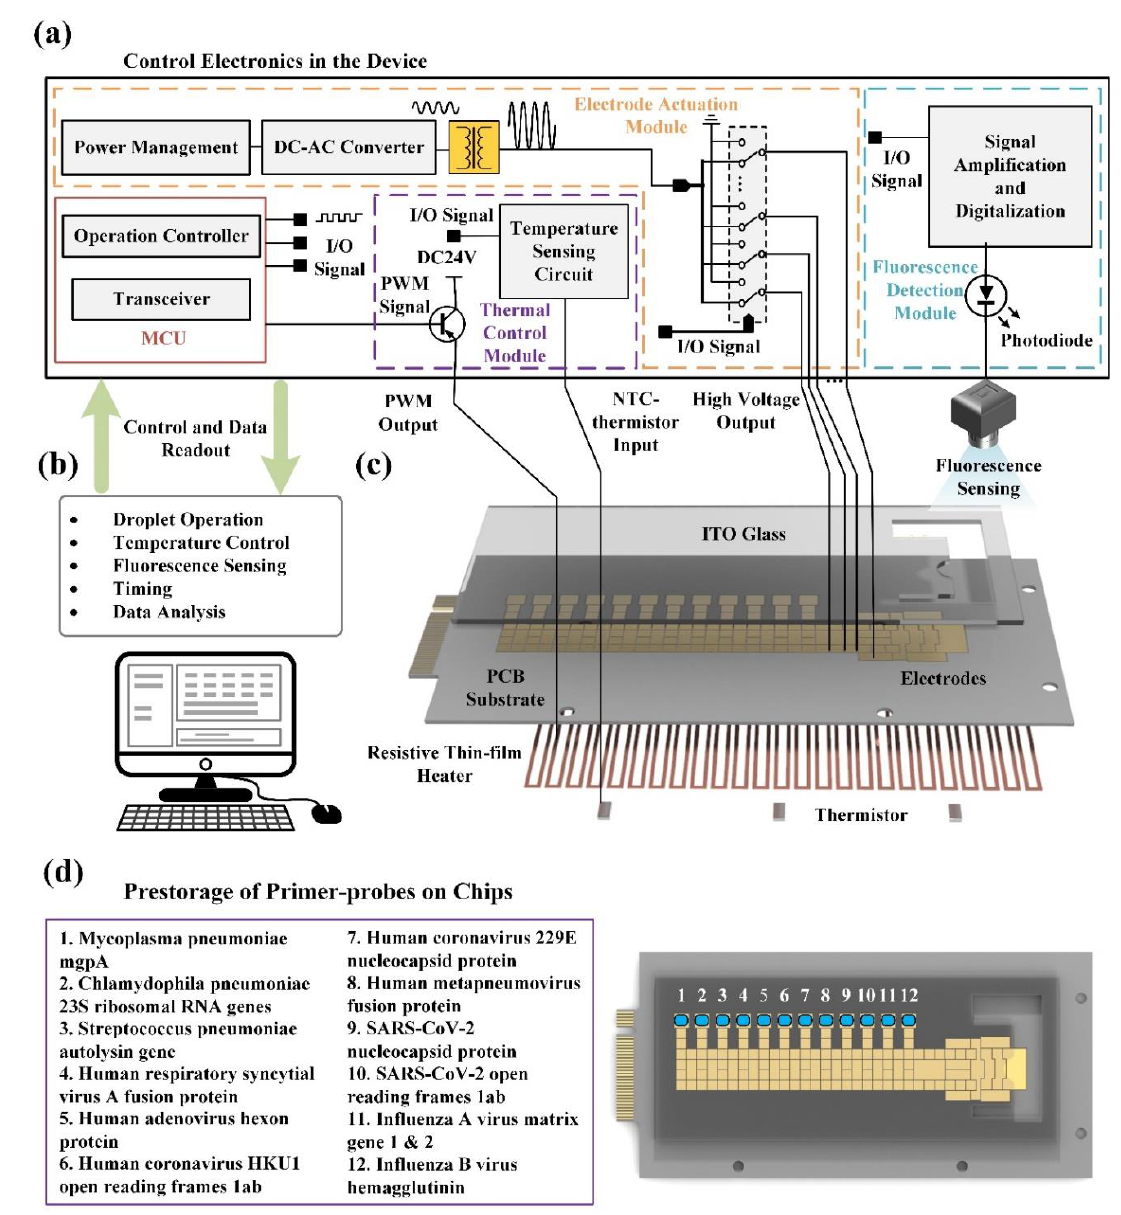
Figure 2. The overview of the DMF system configuration. ( a ) The control electronics in the device; ( b ) The customized and user-programmable software on the PC; ( c ) A 3D explosion diagram of the proposed DMF chip; ( d ) The prestorage of corresponding primer – probe pairs on-chip.